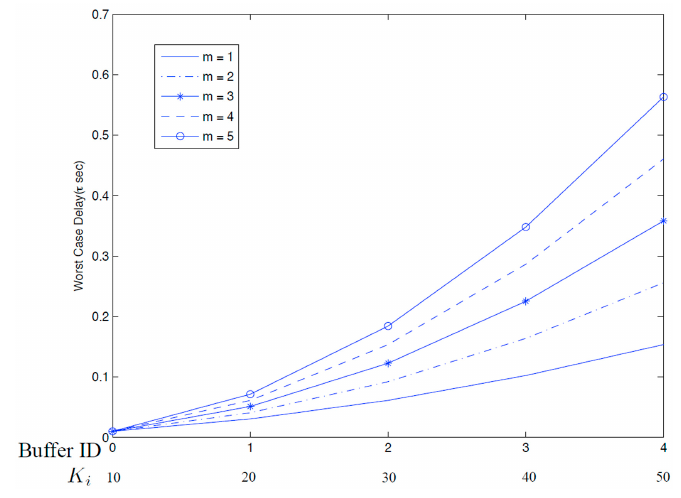
Figure 10. Worst-case delays for buffers when M = 4 and m = 1, 2, …, 5.